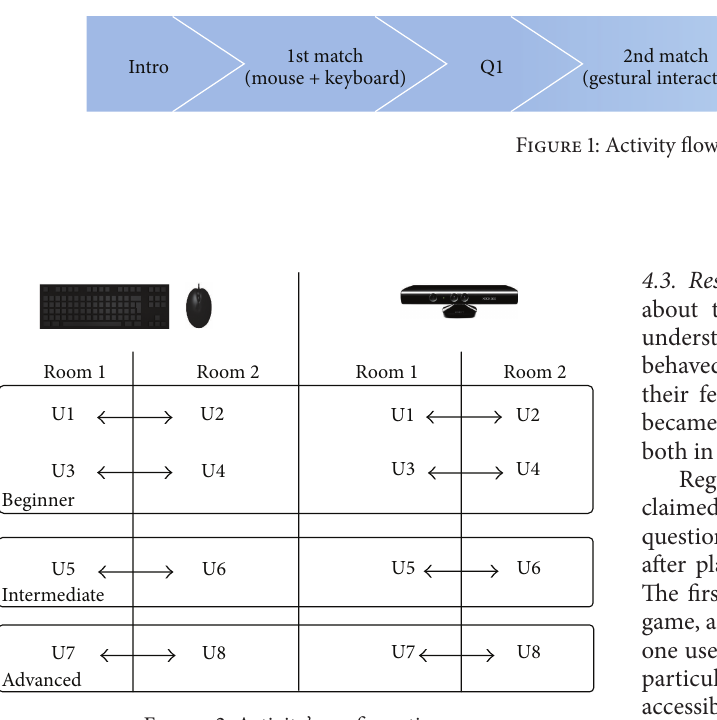
Figure 2: Activity’s